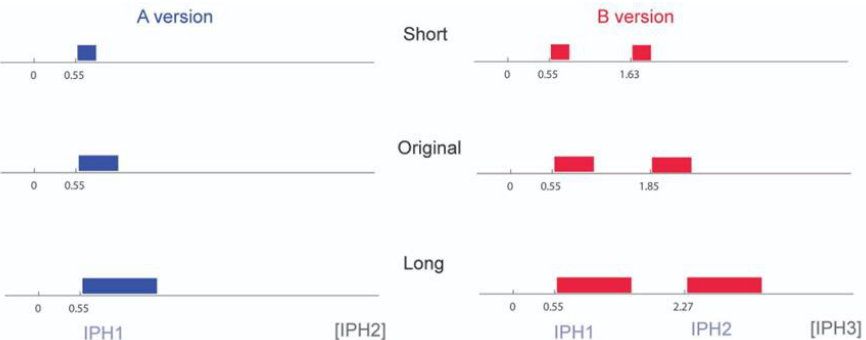
Figure 2. IPH boundaries (rectangles represent last stressed syllable of each IPH) at A and B versions, for short vs. original vs. long stimulus sets. For EEG analysis, IPH2 boundaries in A versions were copied from B versions.